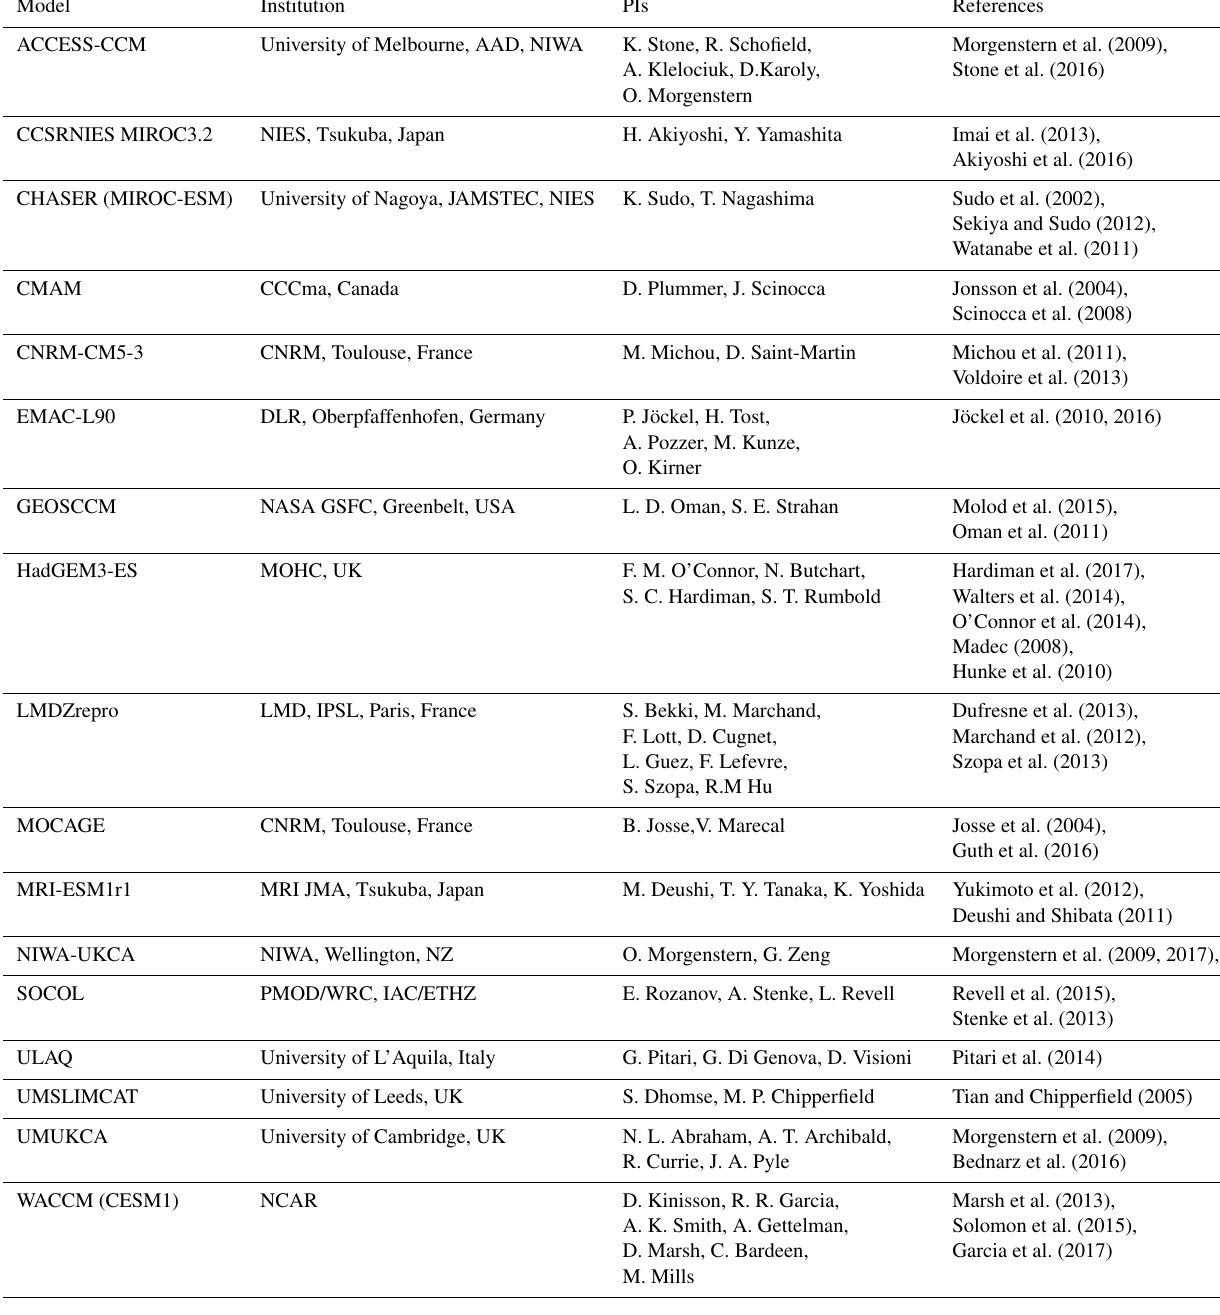
Table 1. CCMI Model with principal investigators (PIs) and institutions.